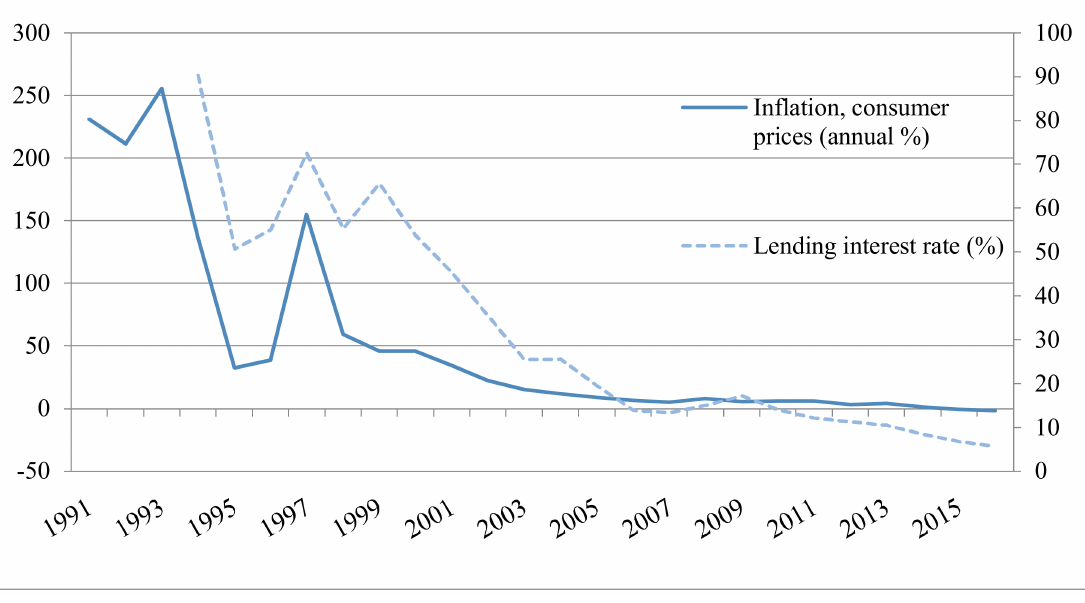
Figure 2. Inflation vs lending interest rate. Source: Authors’ own processing using World Bank